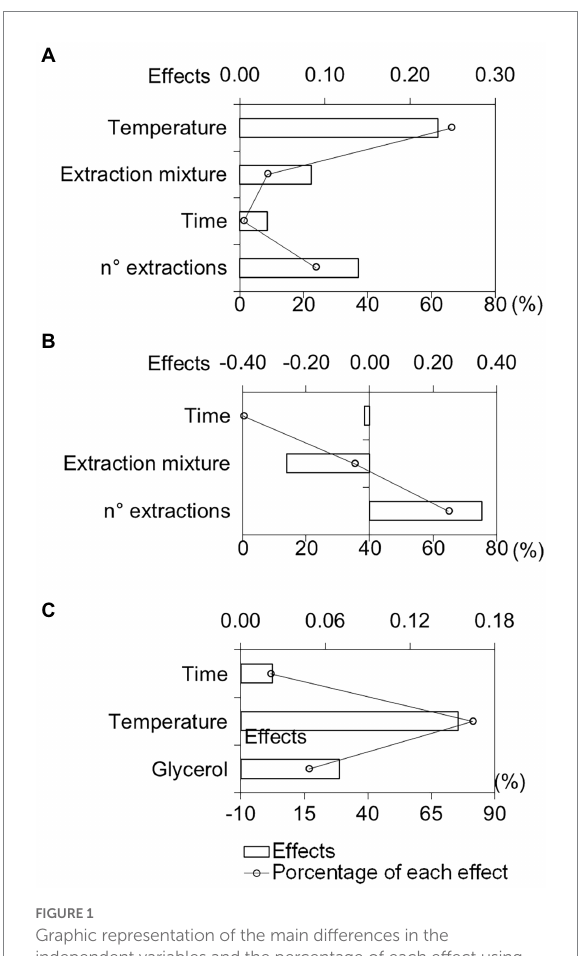
FIGURE 1 Graphic representation of the main differences in the independent variables and the percentage of each effect using solid–liquid extraction (A) , solid–liquid extraction assisted by ultrasound bath (B) , and headspace extraction (C)